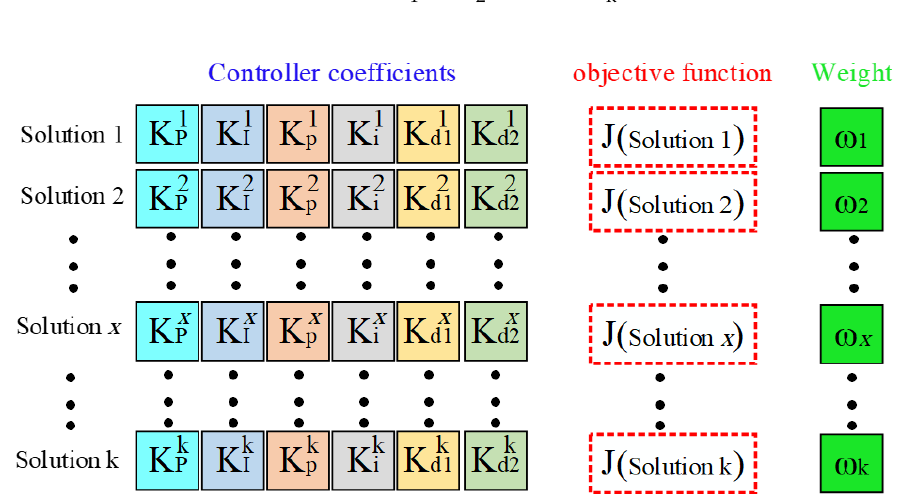
Figure 11. Solution archive.